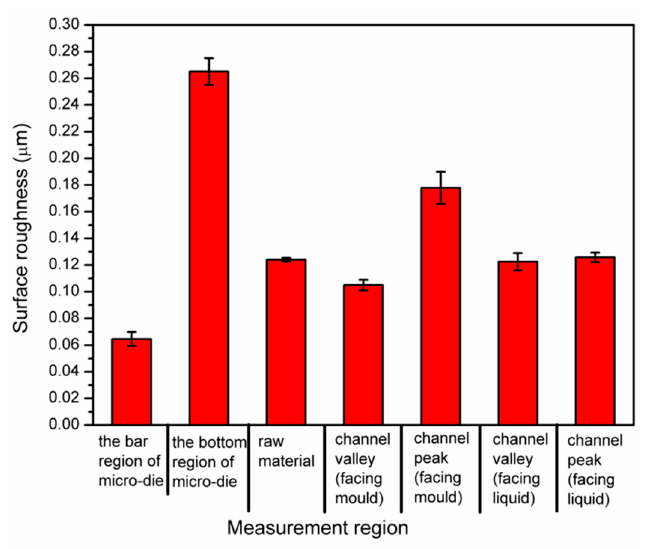
Figure 26. Surface roughness values of the corresponding regions and the micro ‐ die.